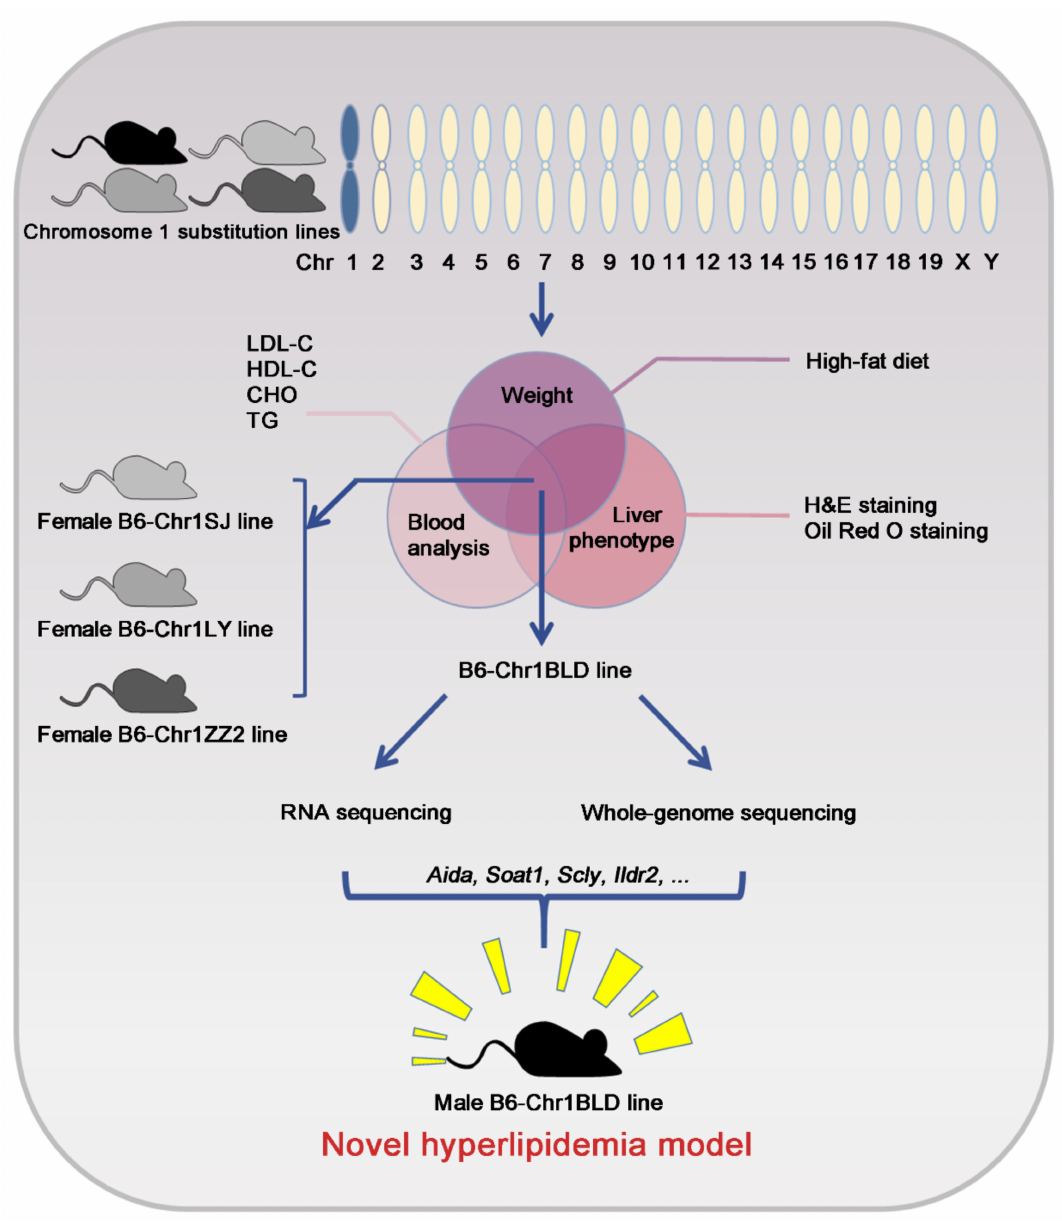
Figure 9. Identification of chromosome 1 substitution lines as novel hyperlipidemia models via phenotyping